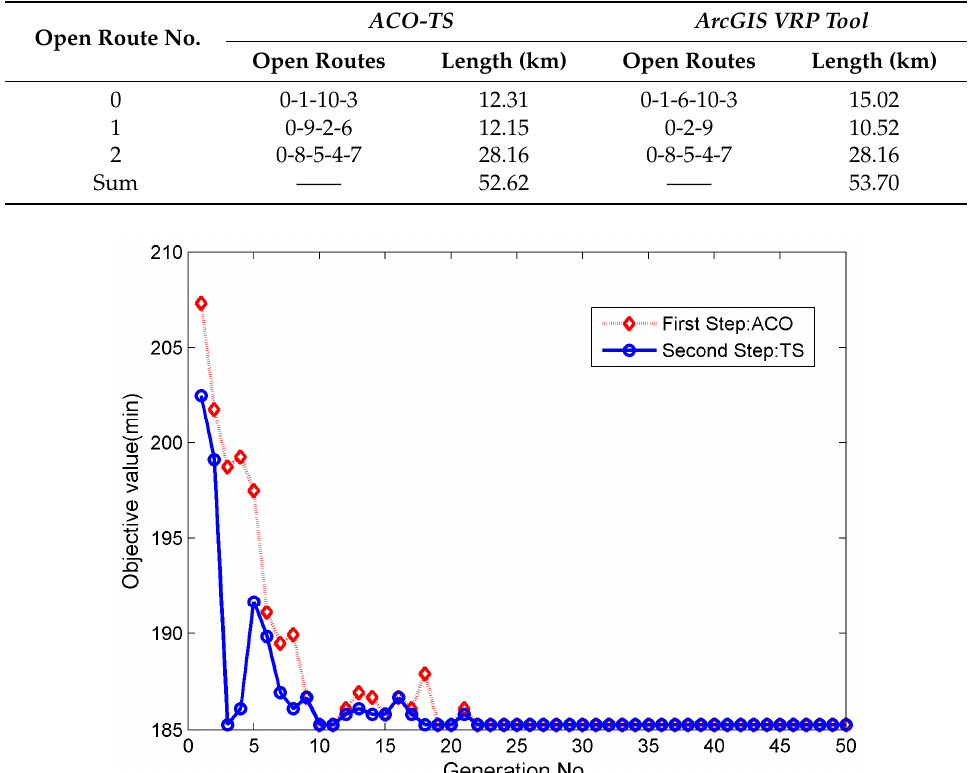
Table 6. Rescue route performances of the ACO-TS and the ArcGIS VRP tool.